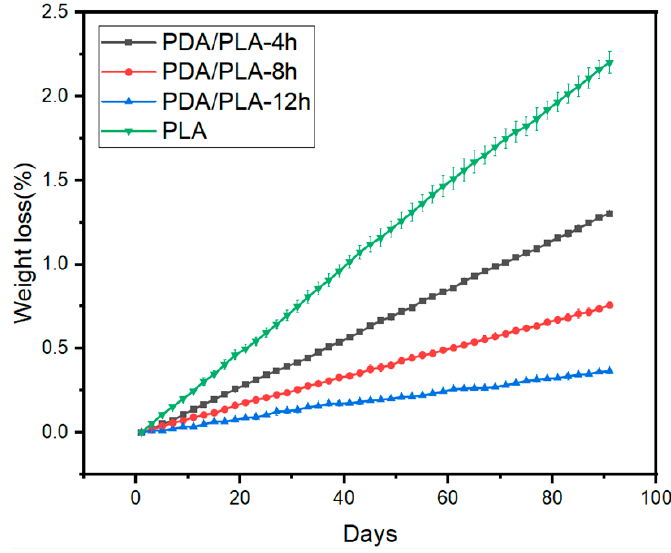
Figure 8. Weight loss of PLA and PDA/PLA samples degradation in PBS buffer.